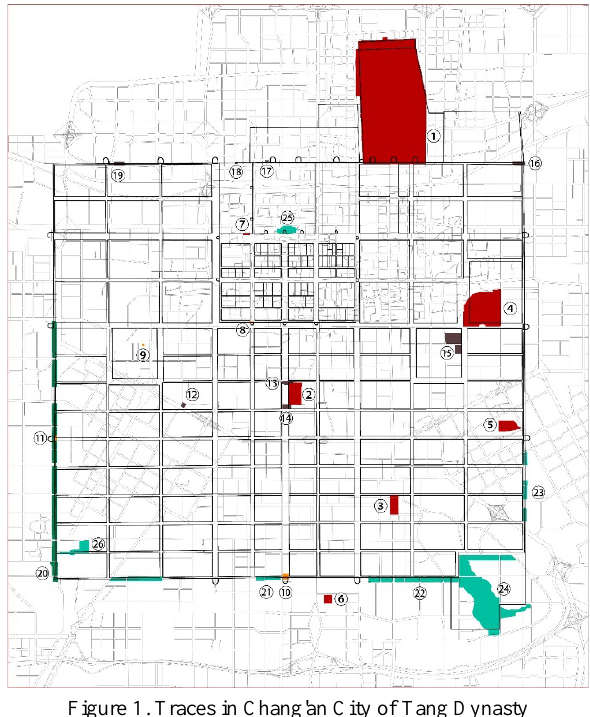
Figure 1. Traces in Chang'an City of Tang Dynasty （ Remains ）